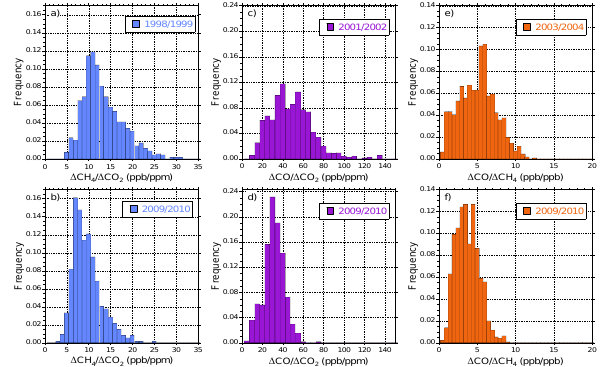
Fig. 6. Histograms of the correlation slopes of ( a , b ) 1 CH 4 / 1 CO 2 , ( c , d ) 1 CO/ 1 CO 2 , and ( e , f ) 1 CO/ 1 CH 4 for the selected two periods. The correlation slopes all meet the selection criteria (see